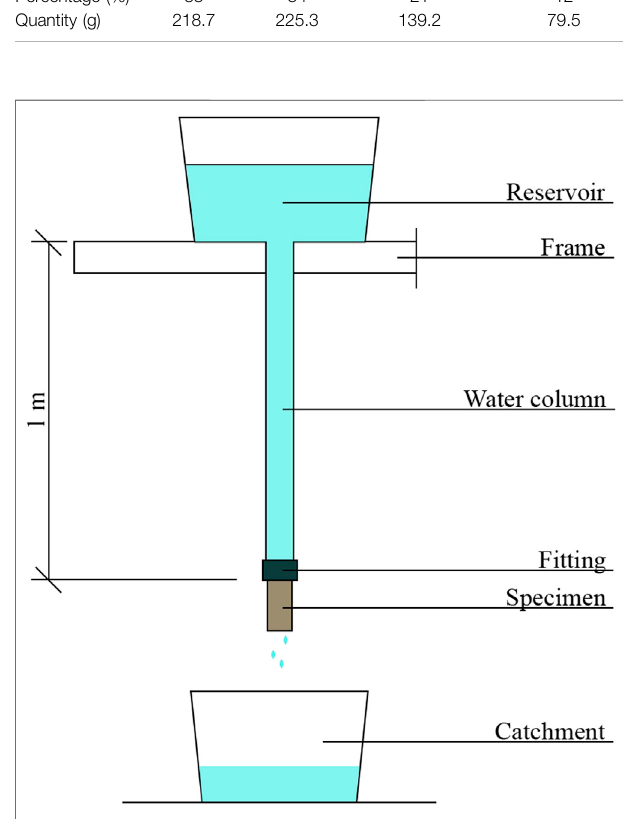
FIGURE 1 | Water permeability test